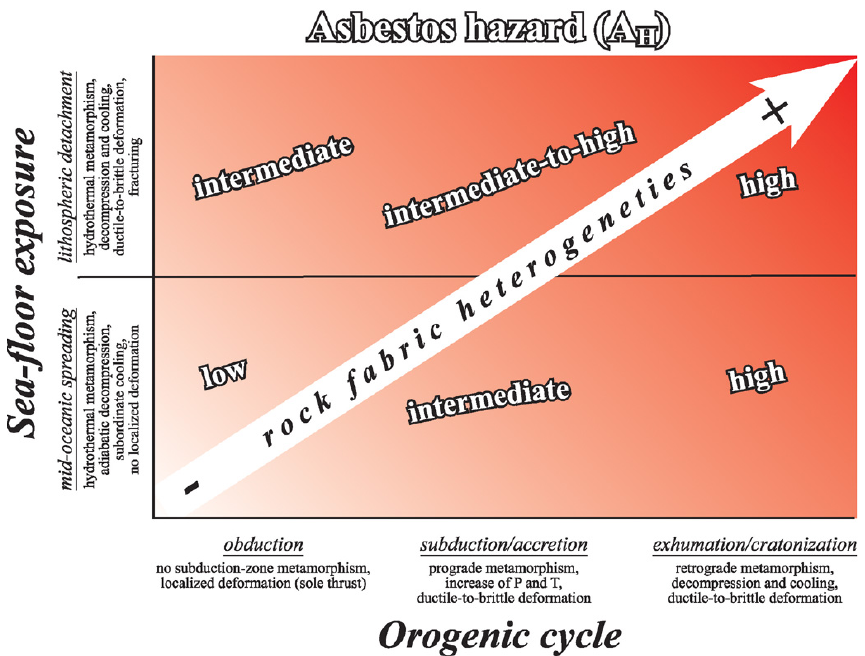
Fig. 7. Schematic diagram correlating the asbestos hazard in ophiolites ( A H ) to the modality of sea-floor exposure and different orogenic stages. The A H is expressed as a spectrum of possibilities directly connected to the rock fabric heterogeneities (ductile-to-brittle deformation localization, metamorphism/metasomatism, and fluid flux) that are representative of the tectonic environments. The diagram suggests that A H increases in ophiolites where a larger variety of deformation structures and associated metamorphic mineralisation can be expected due to the progressive superimposition of chronologically distinct tectono-metamorphic